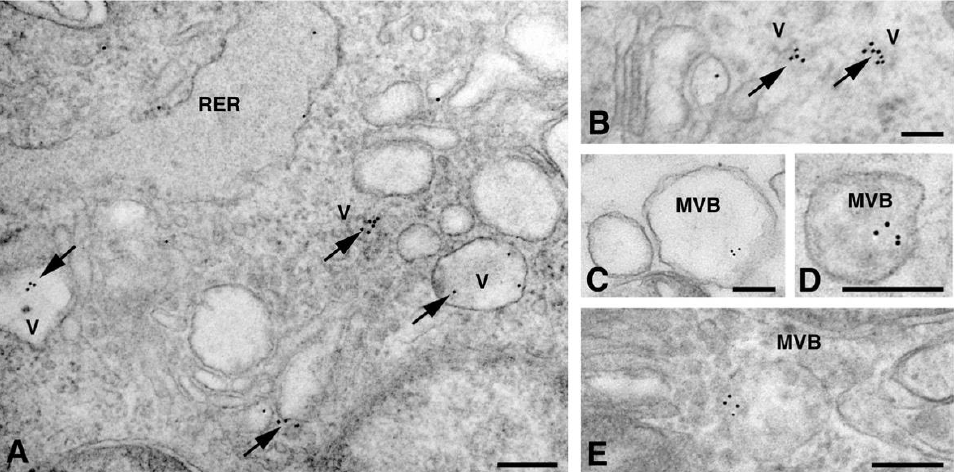
Figure 2. TEM immunogold analysis for Cx26 in dH9c2 cytoplasmic vesicles. ( A , B ) Arrows point to gold particles on different sized vesicles (V). ( C – E ) Representative images of multivesicular bodies (MVB) showing immunoreactivity. Scale bars 200 nm ( A , C – E ), 100 nm ( B ). RER, rough endoplasmic reticulum.